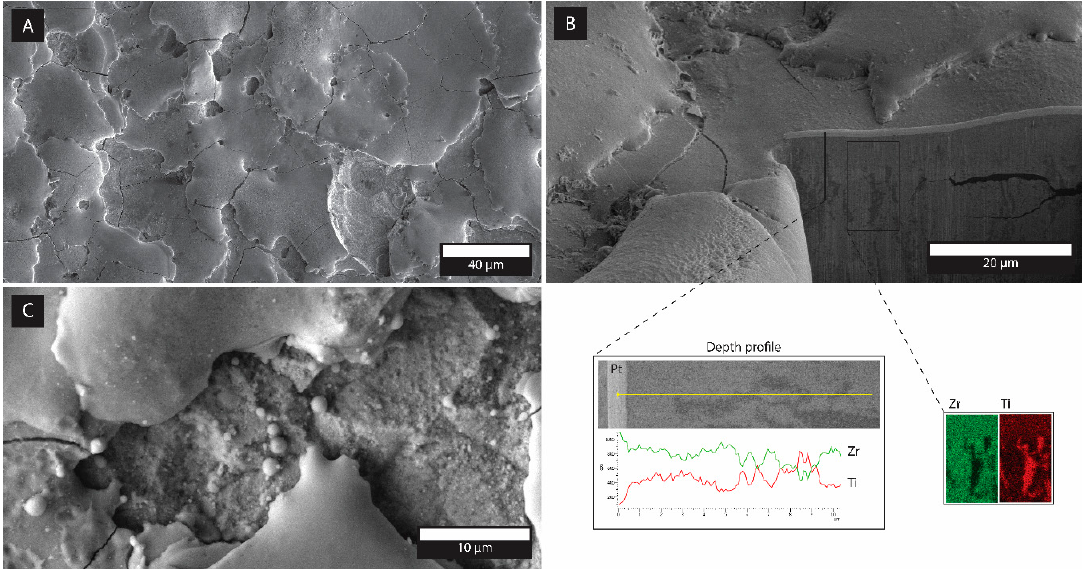
Figure 8. Back-scattered SEM micrographs of EDM-machined 30 vol% TiN–ZrO 2 _ISS ( a ) surfaces ( b ) surface at higher magnification indicating the material–removal mechanisms, and ( c ) subsurface with an inset of the EDS of the area containing the TiN agglomerate.